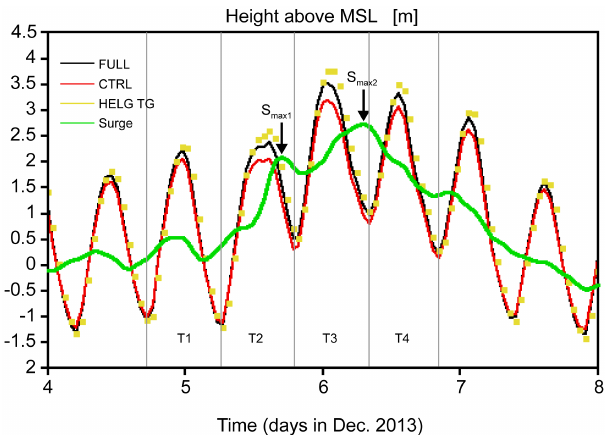
Figure 9. Time series of the mean sea level (MSL) in [m] at the Hel- goland station (see Fig. 1 for its location). Tide gauge observations (yellow); coupled wave–circulation model observations, WAM– GETM (black line); only circulation model, GETM (red line); storm surge (green